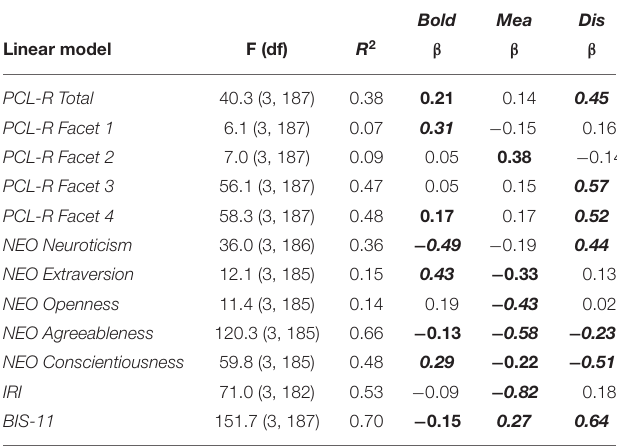
TABLE 2 | Linear regression estimates of the associations between external variables and TriPM Boldness, Meanness and